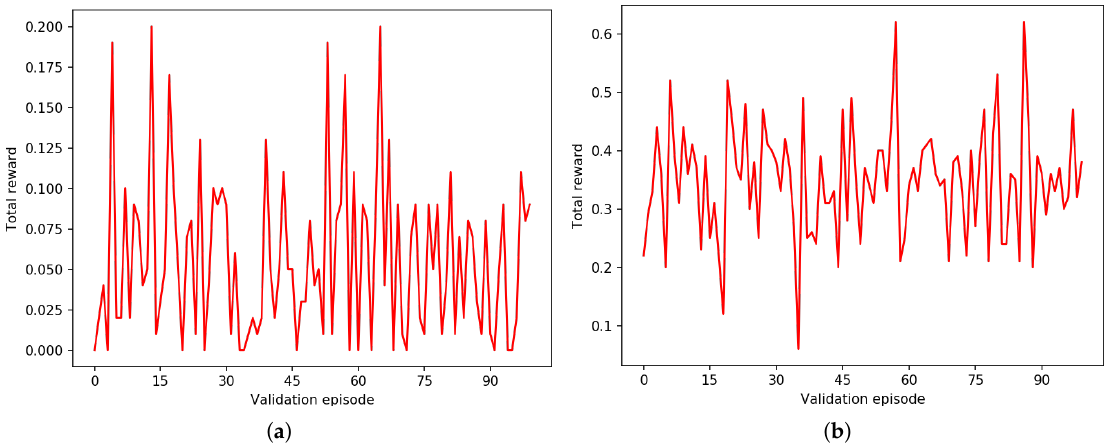
Figure 9. Average total rewards of a random agent on BF and RF for medium sequences. ( a ) ρ BF with B = 200, episodes length T = 100. ( b ) ρ RF with N = 5, episodes length T = 100.